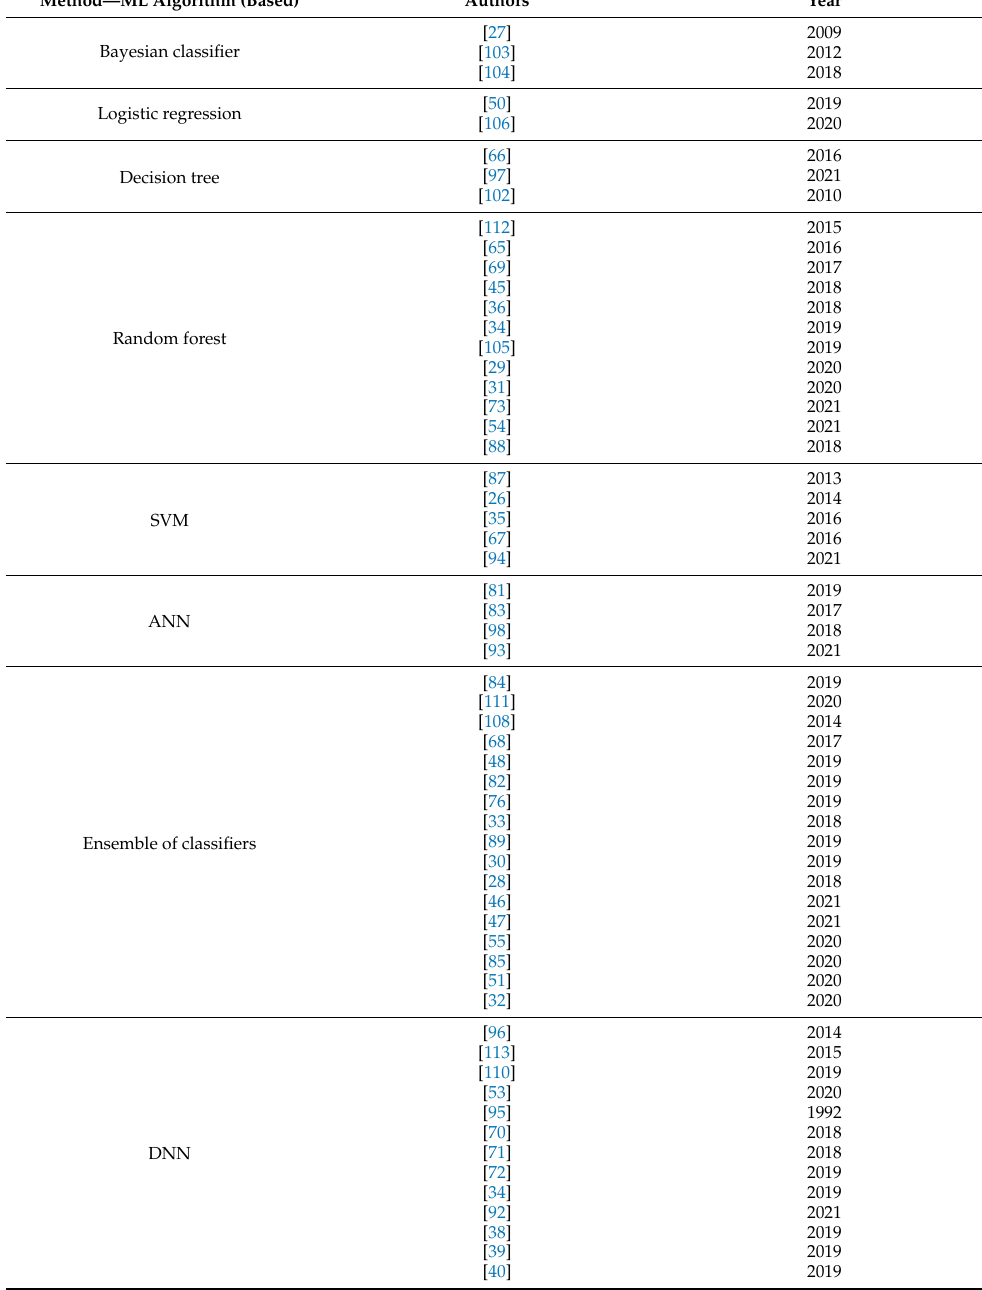
Table 10. Searches grouped by type of ML algorithm applied. Method—ML Algorithm